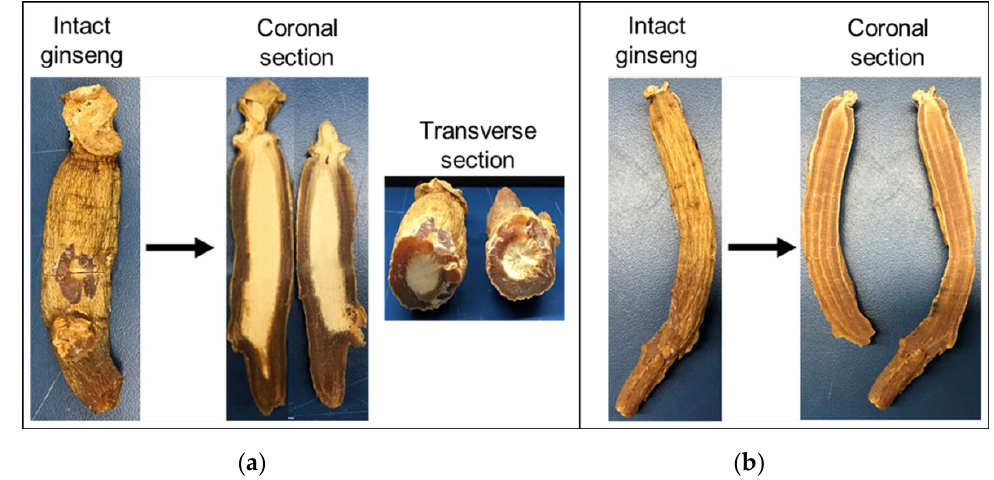
Figure 1. Example of an abnormal and normal ginseng sample. ( a ) Intact and sliced abnormal ginseng with whitening in center; ( b ) intact and sliced normal ginseng without whitening.